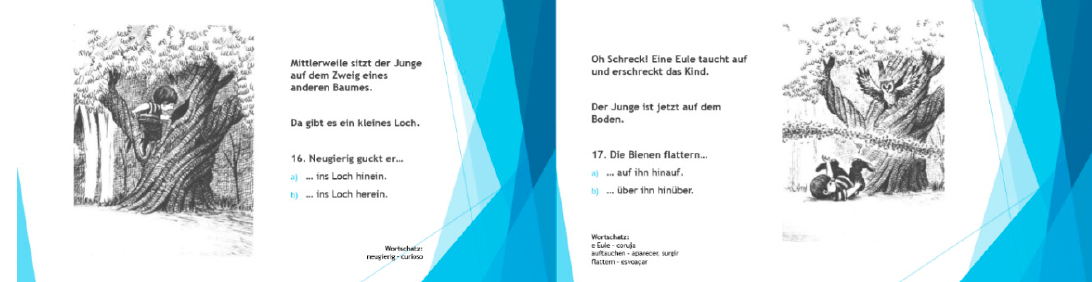
Figure A33. Posttest: Binary-choice recognition task.